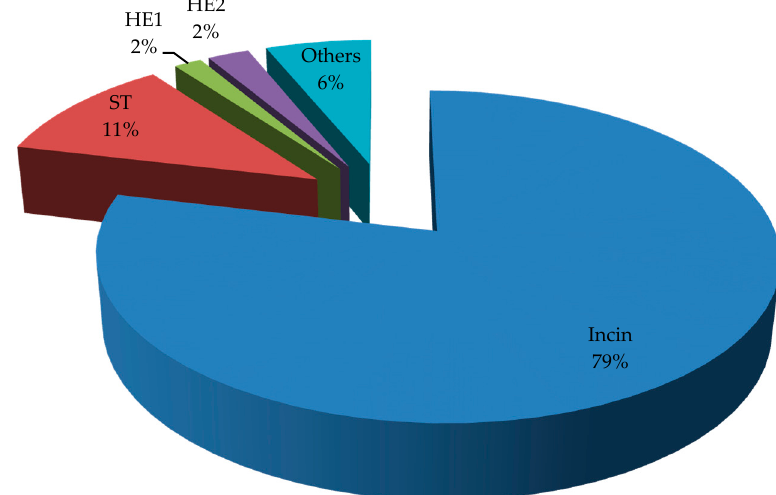
Figure 3. Investment capital breakdown of the proposed CCHP